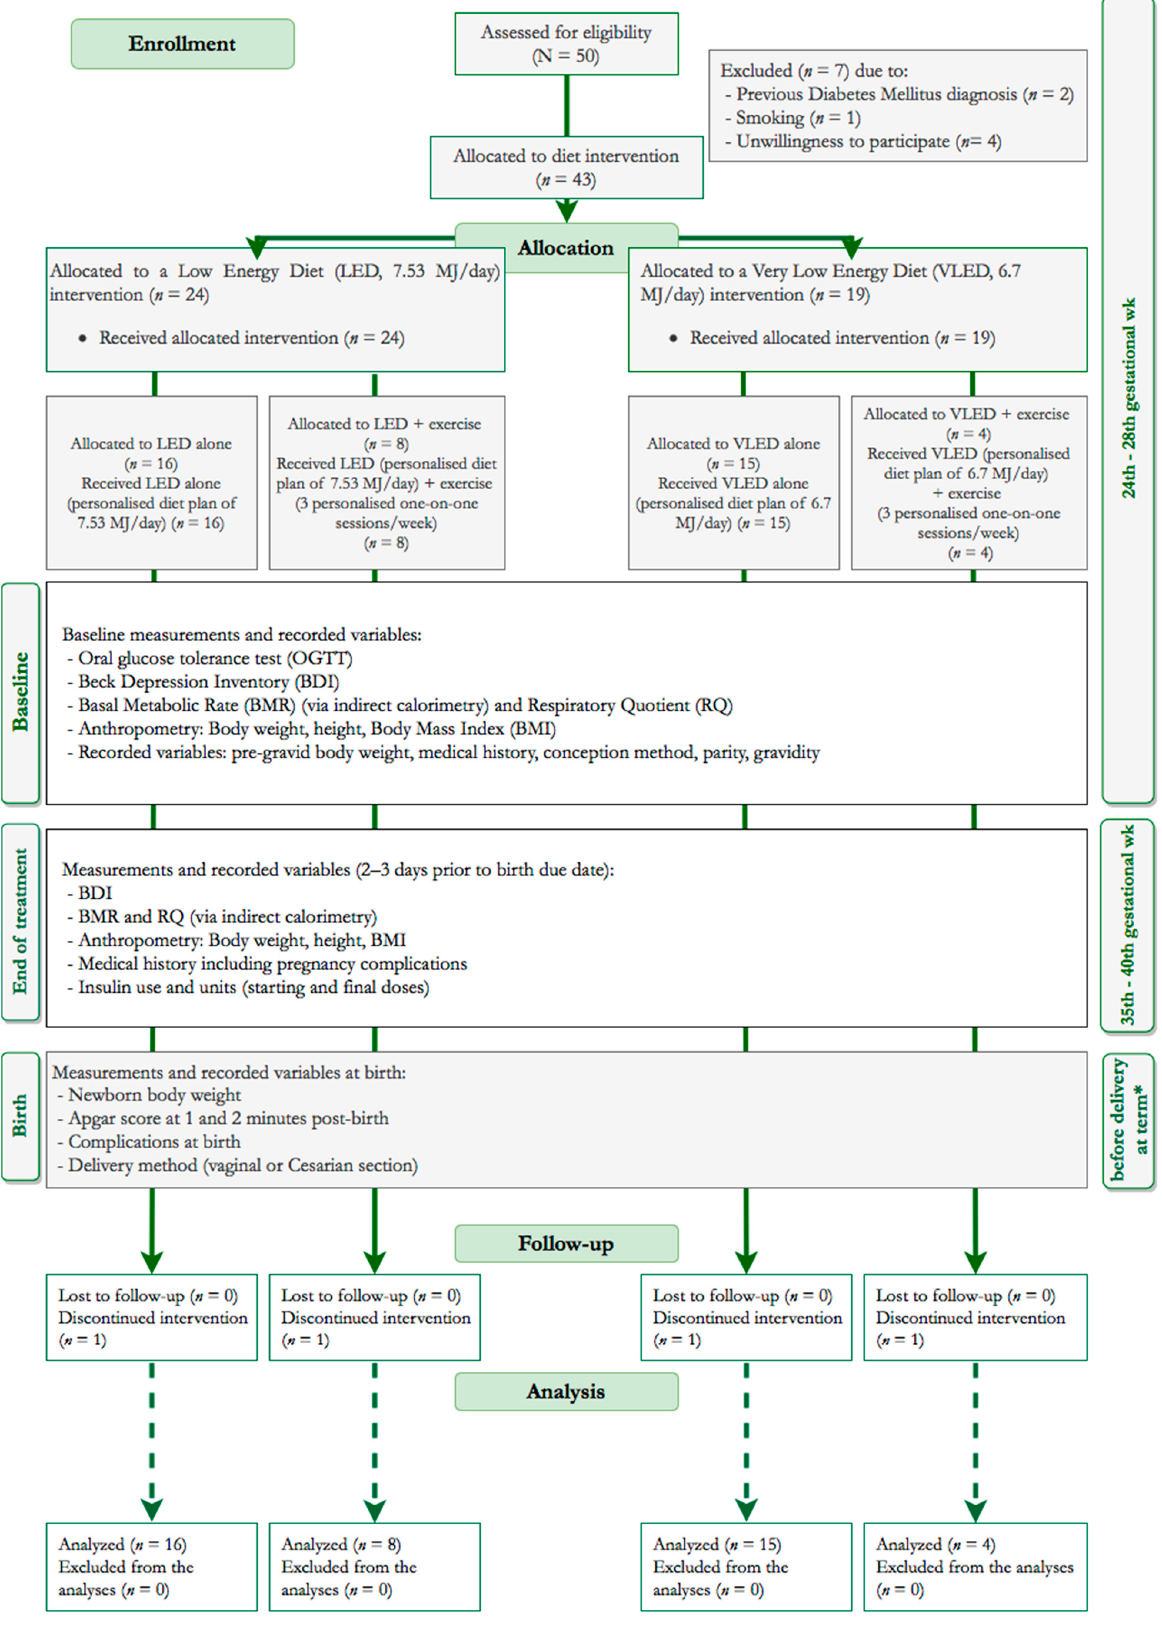
Figure 1. TREND diagram of the study’s process. * 2–3 days before the birth due date or imputed to the population mean when data were not available.